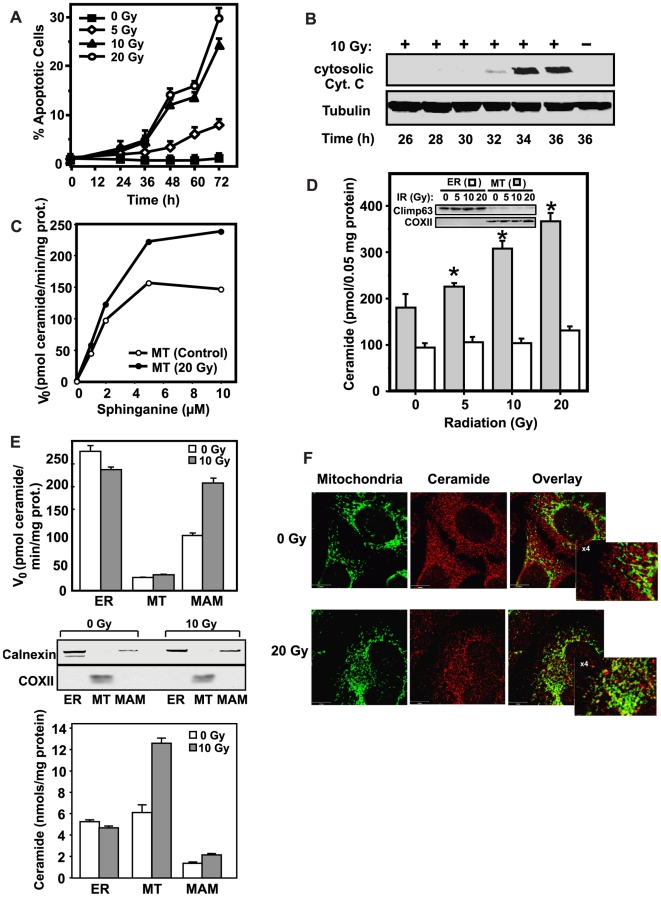
Ionizing radiation-induced ceramide elevation is confined to mitochondria.(A) Time- and dose-dependent induction of apoptosis in response to ionizing radiation. Morphologic changes of nuclear apoptosis were detected using the DNA-specific fluorochrome bis-benzimide. Data (mean±SEM) are collated from 3 experiments analyzing 500 cells per point. (B) Time-dependent cytochrome c (Cyt. c) release after 10 Gy. Cytosolic fractions of HeLa cells, collected at the indicated times post-irradiation were analyzed by immunoblotting using α-Cyt. c. Data are from 1 representative of 3 studies. (C) Increased CS activity in isolated mitochondria (MT) after 20 Gy. CS activity was measured at 28 h post-irradiation. Data are from 2 experiments. (D) Radiation increases mitochondrial ceramide content. At 33 h post-irradiation, ceramide was quantified by the diacylglycerol kinase assay in mitochondrial-enriched and ER-enriched fractions from HeLa cells. Inset: The ER-enriched fraction was devoid of mitochondrial contamination based on western blotting with anti-COXII (mitochondrial marker), while the mitochondrial fraction was 10.9±1.7% (mean±SE) ER based on anti-Climp63 (ER marker) blotting. Data (mean±SE) are from 4 experiments performed in triplicate. *, p<0.05 vs. control. (E) Ionizing radiation increases CS activity in MAM and ceramide levels in MAM-free mitochondria (MT). HeLa cells were harvested 33 h post-10 Gy and organelles isolated as in Materials and Methods. ER (P100) was fractionated by differential centrifugation and mitochondria and MAM within the heavy membrane fraction (P10) were further separated from each other by 30% Percoll gradient. Upper panel; CS activity was measured in each fraction using sphinganine and palmitoyl-CoA as substrates as in Materials and Methods. Middle panel: purity of ER, Mitochondria and MAM fractions was analyzed by immunoblotting with antibodies to Calnexin (ER marker) and COXII (MT marker). Based on anti-Calnexin blotting, Percoll-purified mitochondria were 3–4% contaminated with ER. Lower panel; Ceramide levels were quantified by diacylglycerol kinase assay as in Materials and Methods. (F) Co-localization of mitochondrial ceramide and COXI after 20 Gy. At 33 h post-irradiation, HeLa cells were stained with anti-ceramide IgM (red) and anti-COXI IgG (green). Images were acquired with a Leica TCS AOBS SP2 confocal microscope equipped with a 63×1.4NA OIL DIC D objective combined with 4× scan zoom, and co-localization (yellow) was analyzed with MetaMorph 7.5 software. Scale bar; 10 µm. Inset images (rectangles) represent 4× magnification of left upper (0 Gy) and left lower (20 Gy) regions for observation of co-localization. Data are from 1 of 5 experiments.